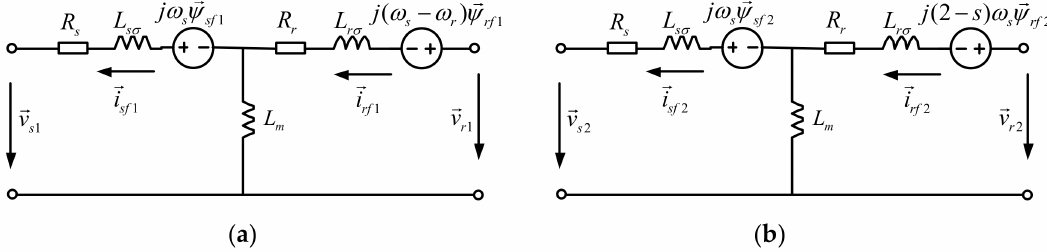
Figure 3. The equivalent circuits of DFIG at the synchronous rotating reference frame: ( a ) the positive sequence equivalent circuit; and ( b ) the negative sequence equivalent